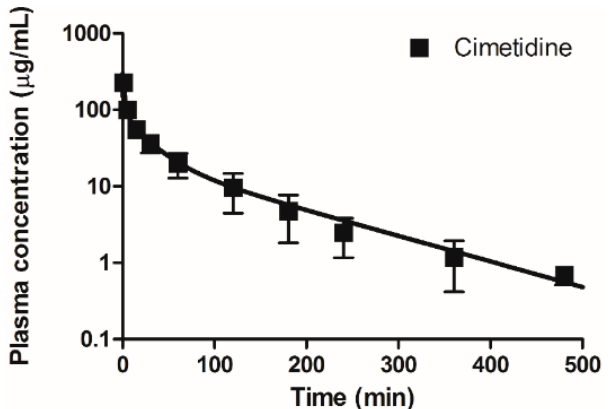
Figure 4. Observed and simulated (i.e., model fitted) plasma concentration-time profiles for cimetidine after intravenous bolus administration of 100 mg/kg of cimetidine. Closed squares and the solid line represent the observed and simulated cimetidine plasma concentrations, respectively ( n = 4 for each point).